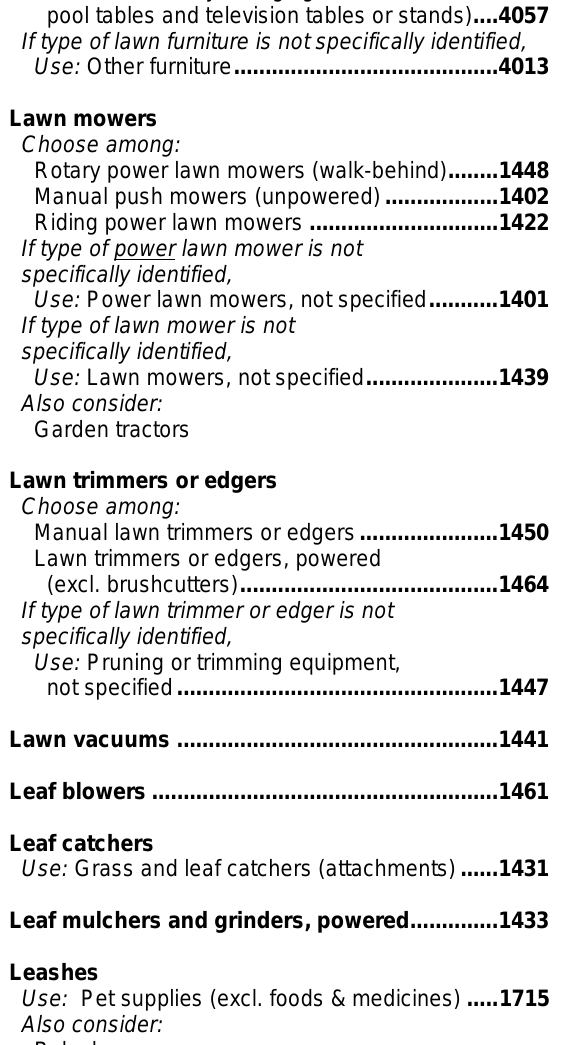
Tables (excl. baby changing tables, billiard or pool tables and television tables or stands) ....